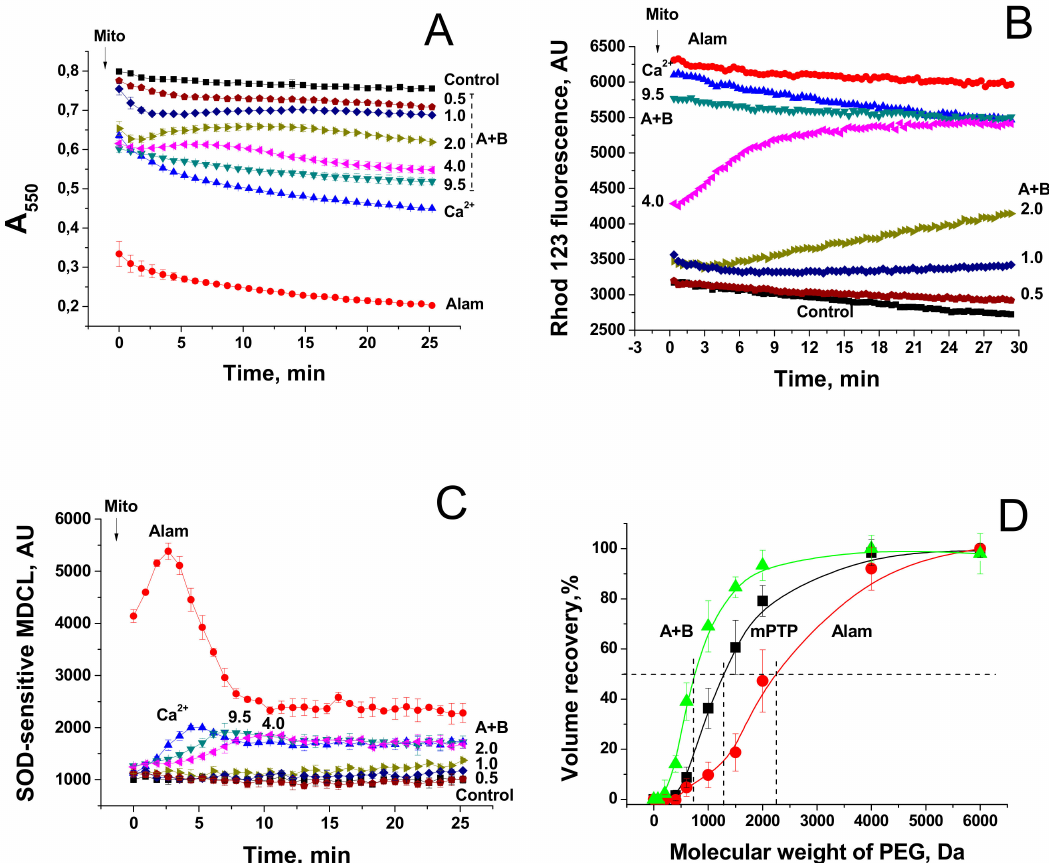
Figure 5. Dynamics of mitochondrial swelling ( A ), ∆Ψ m ( B ), and superoxide anion production ( C ) in mitochondria permeabilized by alamethicin, fusaricidins, and the mPTP inductor Ca 2 + . Comparison of the sizes of mPTP and pores created by fusaricidins and alamethicin ( D ). ( A – C ) Mitochondria (0.5 mg prot. / mL) were added to a standard incubation medium supplemented with 5 mM succinate (plus rotenone 2 µ g / mL), 330 nM rhodamine (Rhod) 123 ( B ), and 20 µ M MCLA (3,7-dihydro-2-methyl-6-(4-methoxyphenyl)imidazol[1,2-a]pyrazine-3-one) ( C ). The arrow shows when mitochondria (Mito) were transferred to wells by alamethicin (Alam, 20 µ g / mL), 200 µ M Ca 2 + , and fusaricidins A + B (fraction 2) at indicated concentrations ( µ g / mL). All samples except those with Ca 2 + contained 1 mM EGTA. Representative traces of one experiment of at least three identical are shown. The data on panels A and C were recorded synchronously. ( C ) Reference wells also contained superoxide dismutase (SOD, 200 U / mL). The SOD-sensitive part of an MDCL (MCLA-derived chemiluminescence) signal is presented. ( D ) Recovery of mitochondrial volume after the addition of PEG of di ff erent molecular weight to mitochondria swollen due to the creation of pores by alamethicin (Alam) (12.5 µ g / mL) and fusaricidins A + B (10.5 µ g / mL) and the opening of the Ca 2 + -dependent mPTP (250 nmol CaCl 2 / mg protein). The data presented are the means ± S.E.M. ( n = 3) for three independent measurements. The experiments were performed at 23 ◦